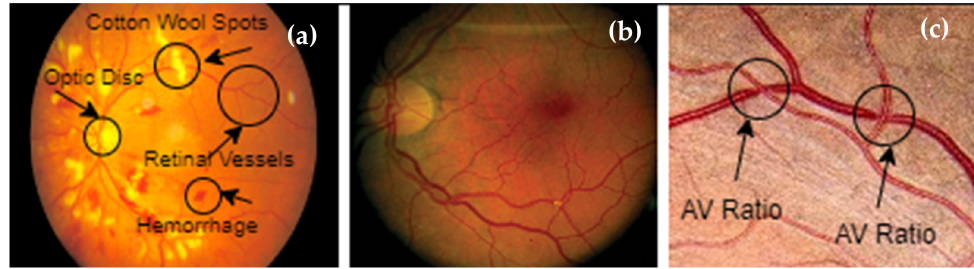
Figure 1. Illustration of the vascular system: ( a ) optic disk, cotton wool spots, and hemorrhages; ( b ) tortuosity; ( c ) A/V ratio.